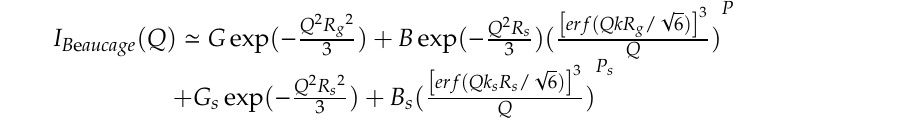
Table 2. Summary of fitting parameters of the nano-sized TATB at the contrast match